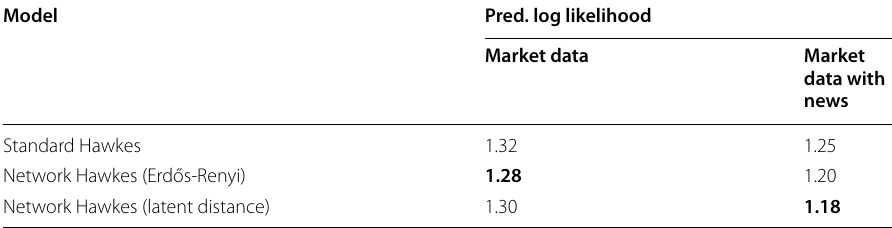
This table represents errors of three models relative to a homogeneous Poisson process on a task of predicting big market moves. The two columns represent comparison of relative error when news data was included into the training and when it was not. Bold values represent which model had the largest improvement in